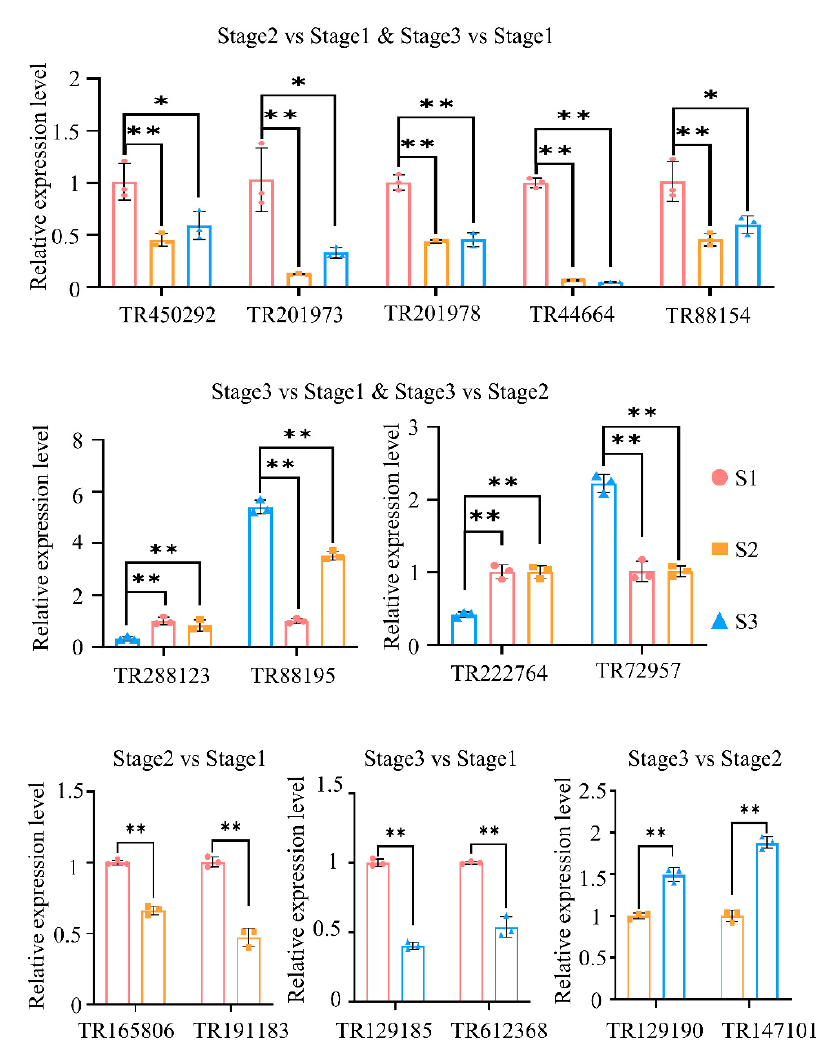
Figure 8. The relative expression levels of the randomly selected differentially expressed genes detected using qRT-PCR. The Actin gene was used as an internal control. S1, S2, and S3 mean stage 1, stage 2, and stage 3, respectively. * and ** means significant difference at the 5% and 1% level using Student’s t -test, respectively.